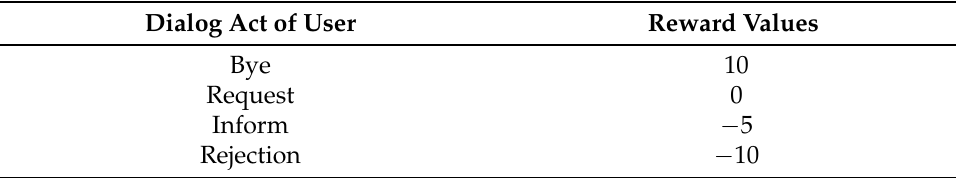
Table 5. Rewards corresponding to each